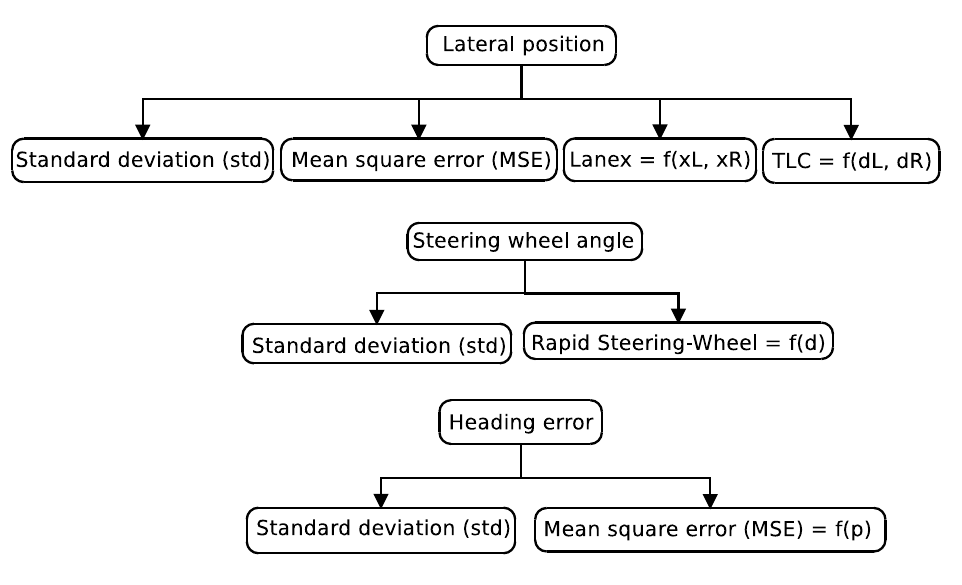
Figure 4. Evaluated indicators.